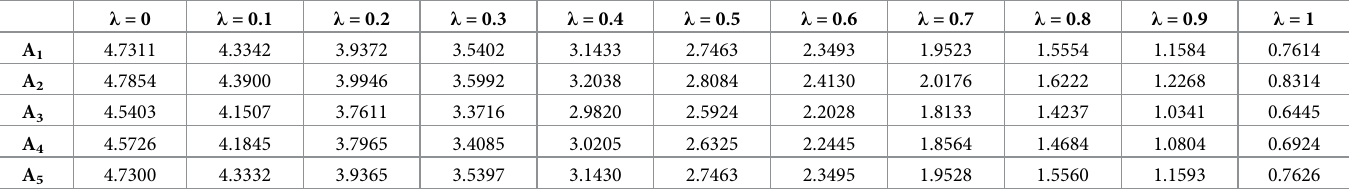
Table 20. The final rank of the alternatives according to the parameter λ .